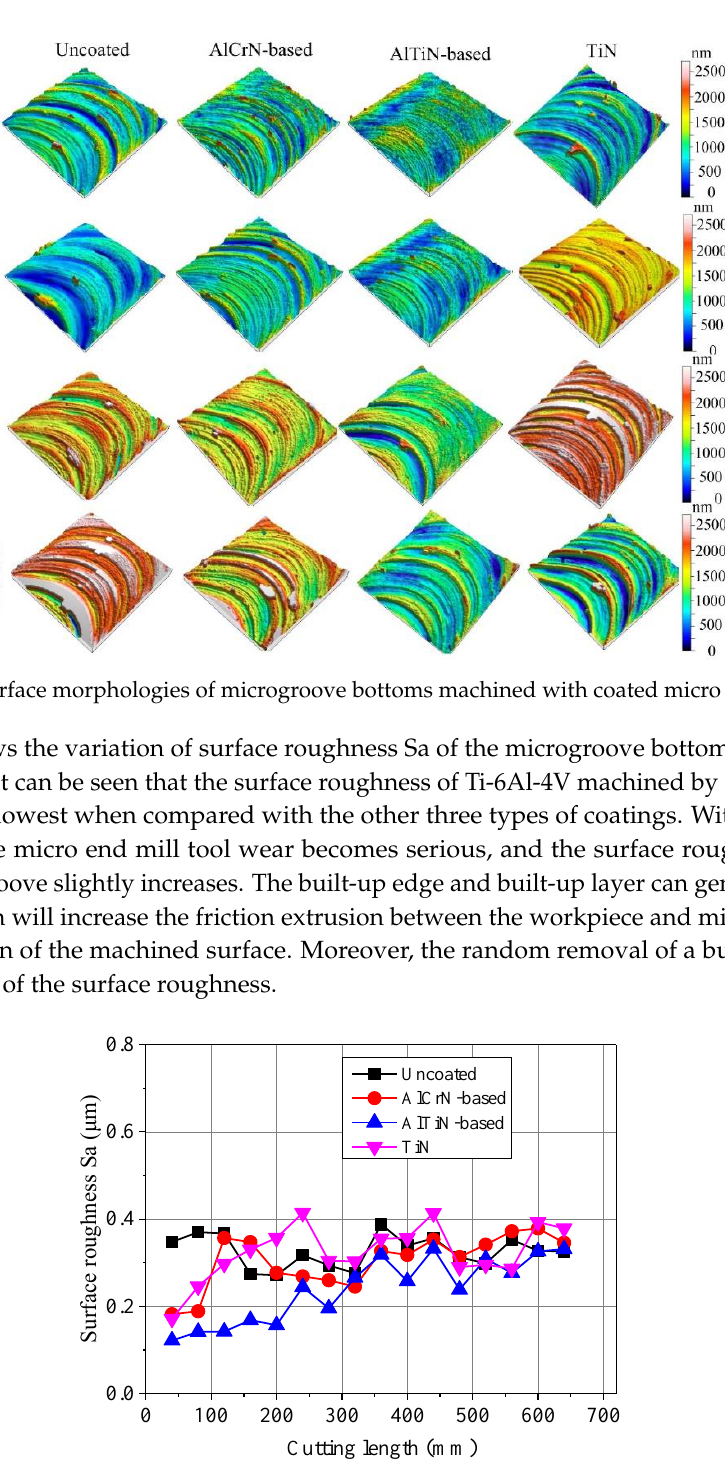
Figure 9. Surface roughness of microgroove bottoms with increased cutting length.